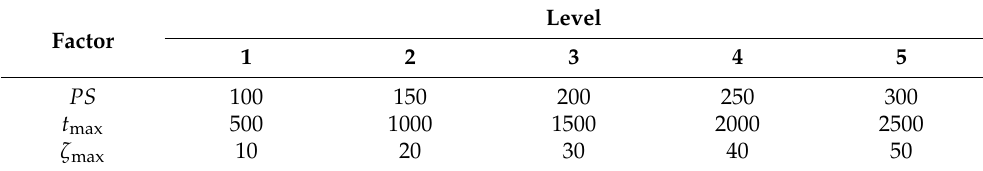
Table 2. Orthogonal array and Avg values.